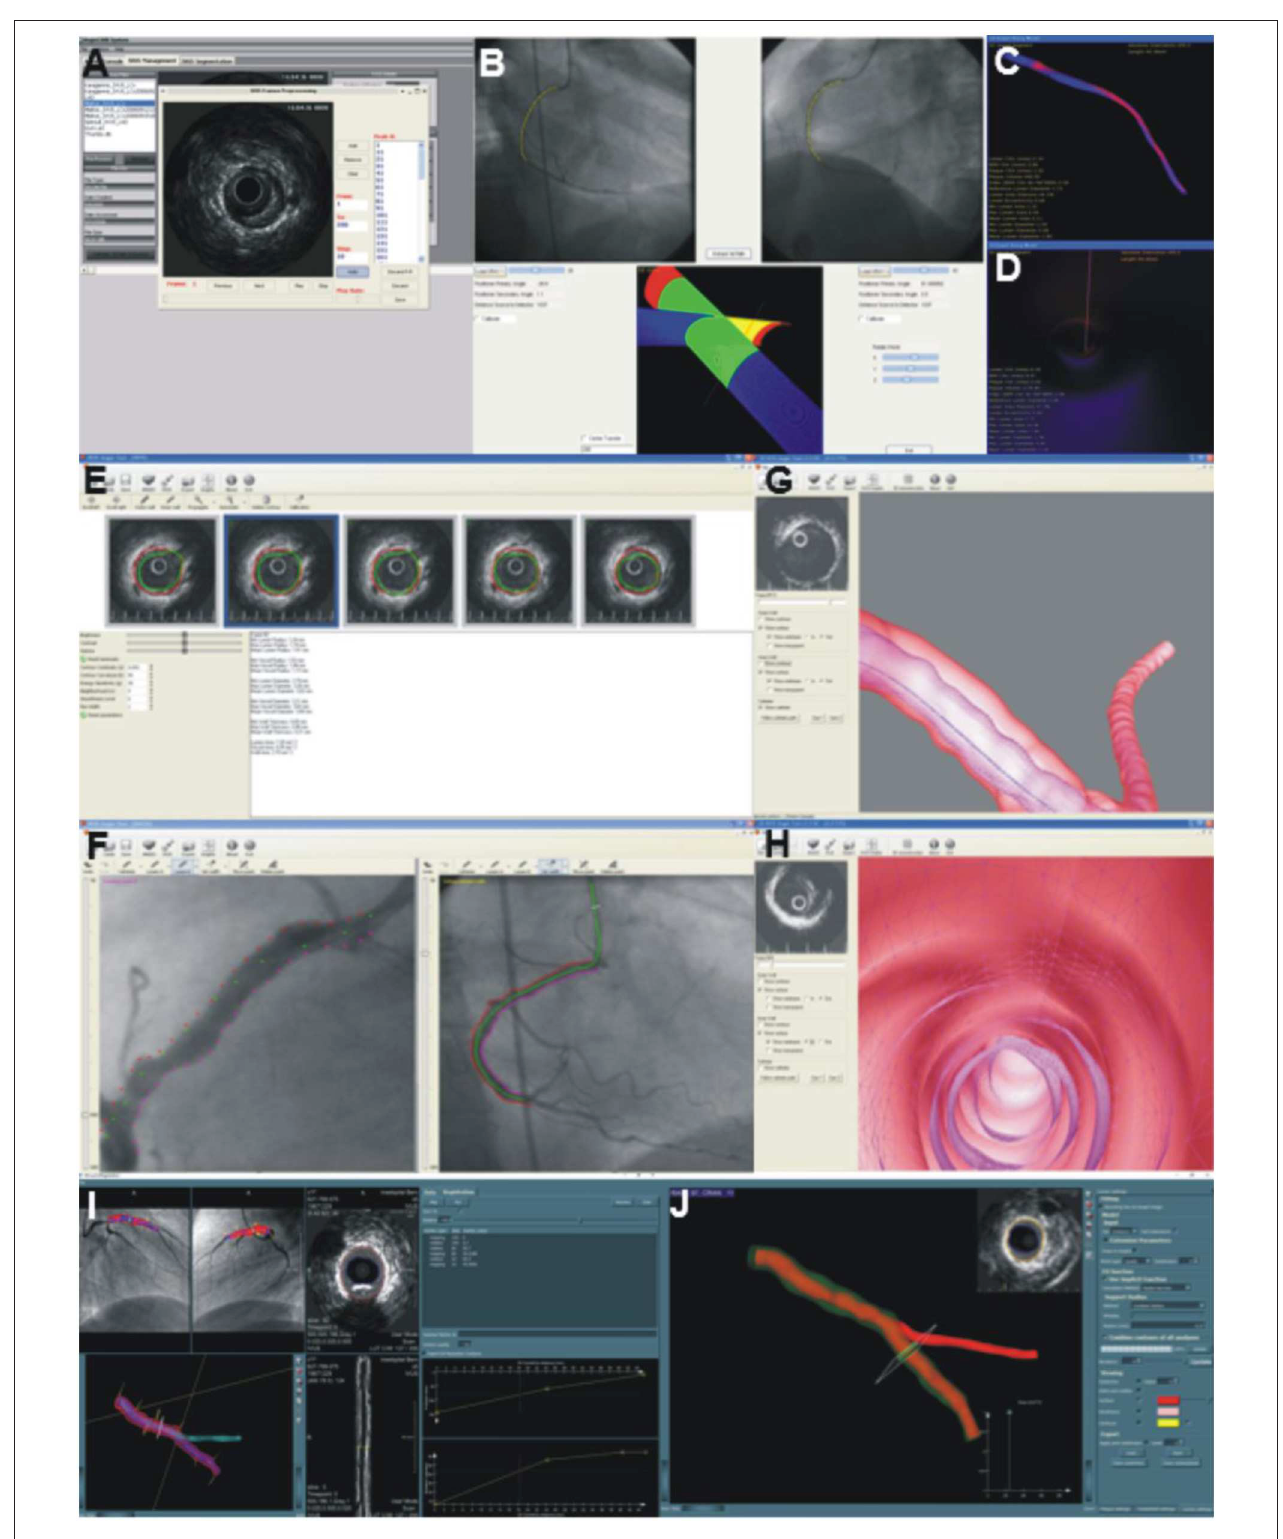
FIGURE 5 | Software developed to reconstruct the coronary artery anatomy in a user-friendly environment. (A–D) portray a snapshot of the ANGIOCARE software. (A) illustrates the module developed for the pre-processing and analysis of intravascular imaging data, while (B) the module designed for the extraction of the catheter